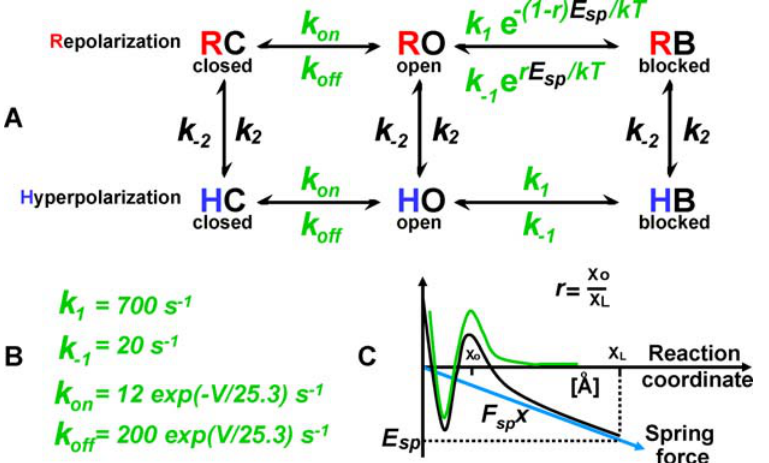
Figure 1. (A) Kinetic model of inactivation and recovery of K + channel. Three pore states: C R closed, O R open, and B R blocked by the inactivating peptide, and two channel substates: R R repolarization (membrane potential less than resting potential), and H R hyperpolarization. The kinetics of recovery is fully determined by three voltage dependent free parameters: a voltage-dependent force of energy E sp applied to the N- terminal peptide, and the on and off rates k 6 2 between the R and H substates. (B) Rates obtained from the literature [8]. (C) The free energy landscapes of the peptide blocking the pore in the depolarized state (green) and during repolarization (black). During repolarization, the peptide is assumed to stretch, exerting a force that contributes to the release of the ball from the pore. The dimensions of the ball and the transition state of the mostly hydrophobic ball-pore complex are estimated to be about X L =13 A˚ and X o =3 A˚ ( , water layer), respectively (see Methods).